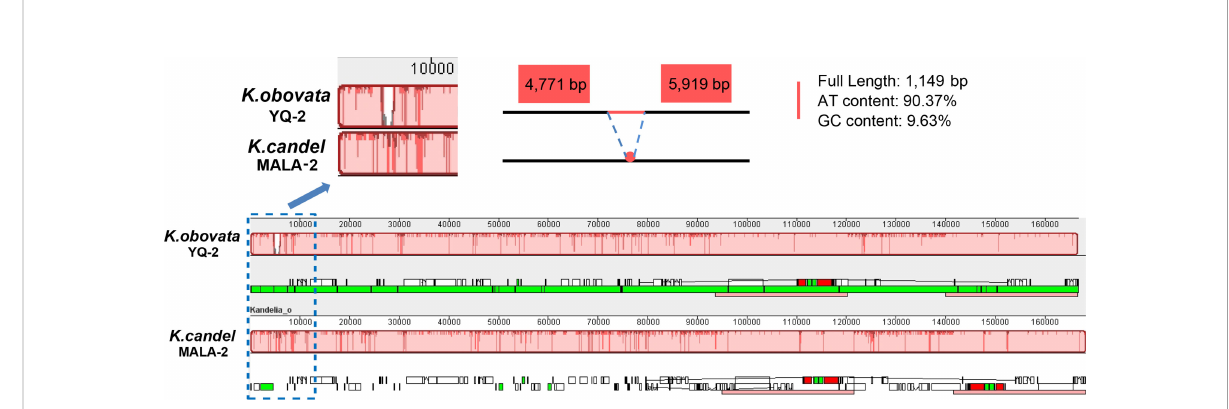
FIGURE 5 Gene map comparison between K.candel and K.obovata chloroplast genomes aligned using Mauve, showing a big ‘ gap ’ of 1,149bp with rich A and T in LSC regions in K. obovata